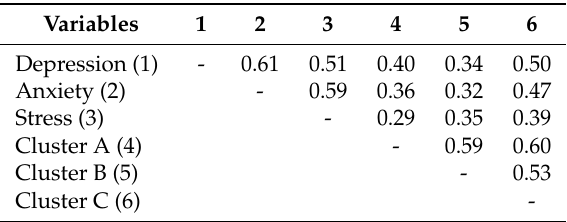
Table 2. Bivariate Pearson correlations between variables among users with an account on Facebook (n = 679).